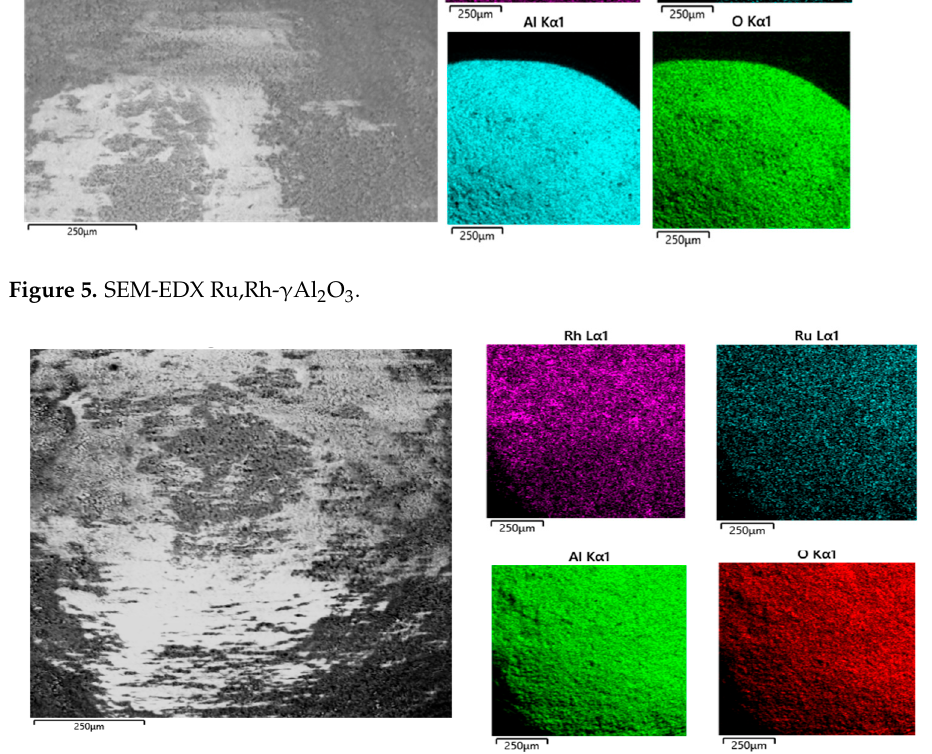
Figure 6. SEM-EDX Rh,Ru- γ Al 2 O 3.